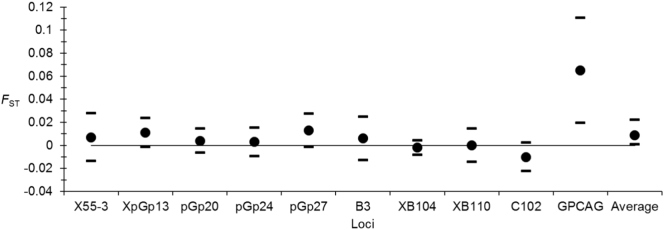
Variation of FST across loci for females Glossina palpalis palpalis from Ivory Coast.